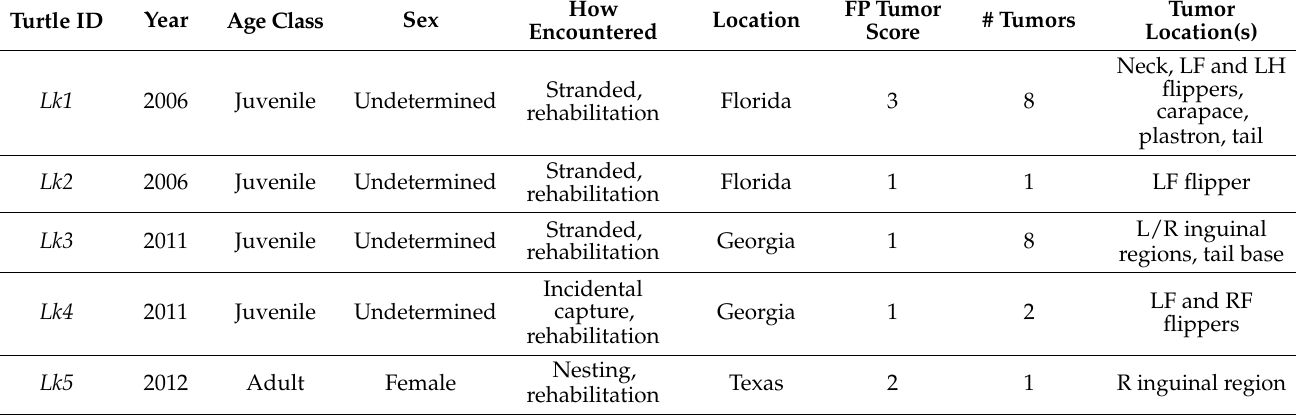
Table 1. Summary case data for Kemp’s ridley sea turtles ( Lepidochelys kempii ) with fibropapillomatosis. * denotes tumor samples analyzed using whole genome shotgun